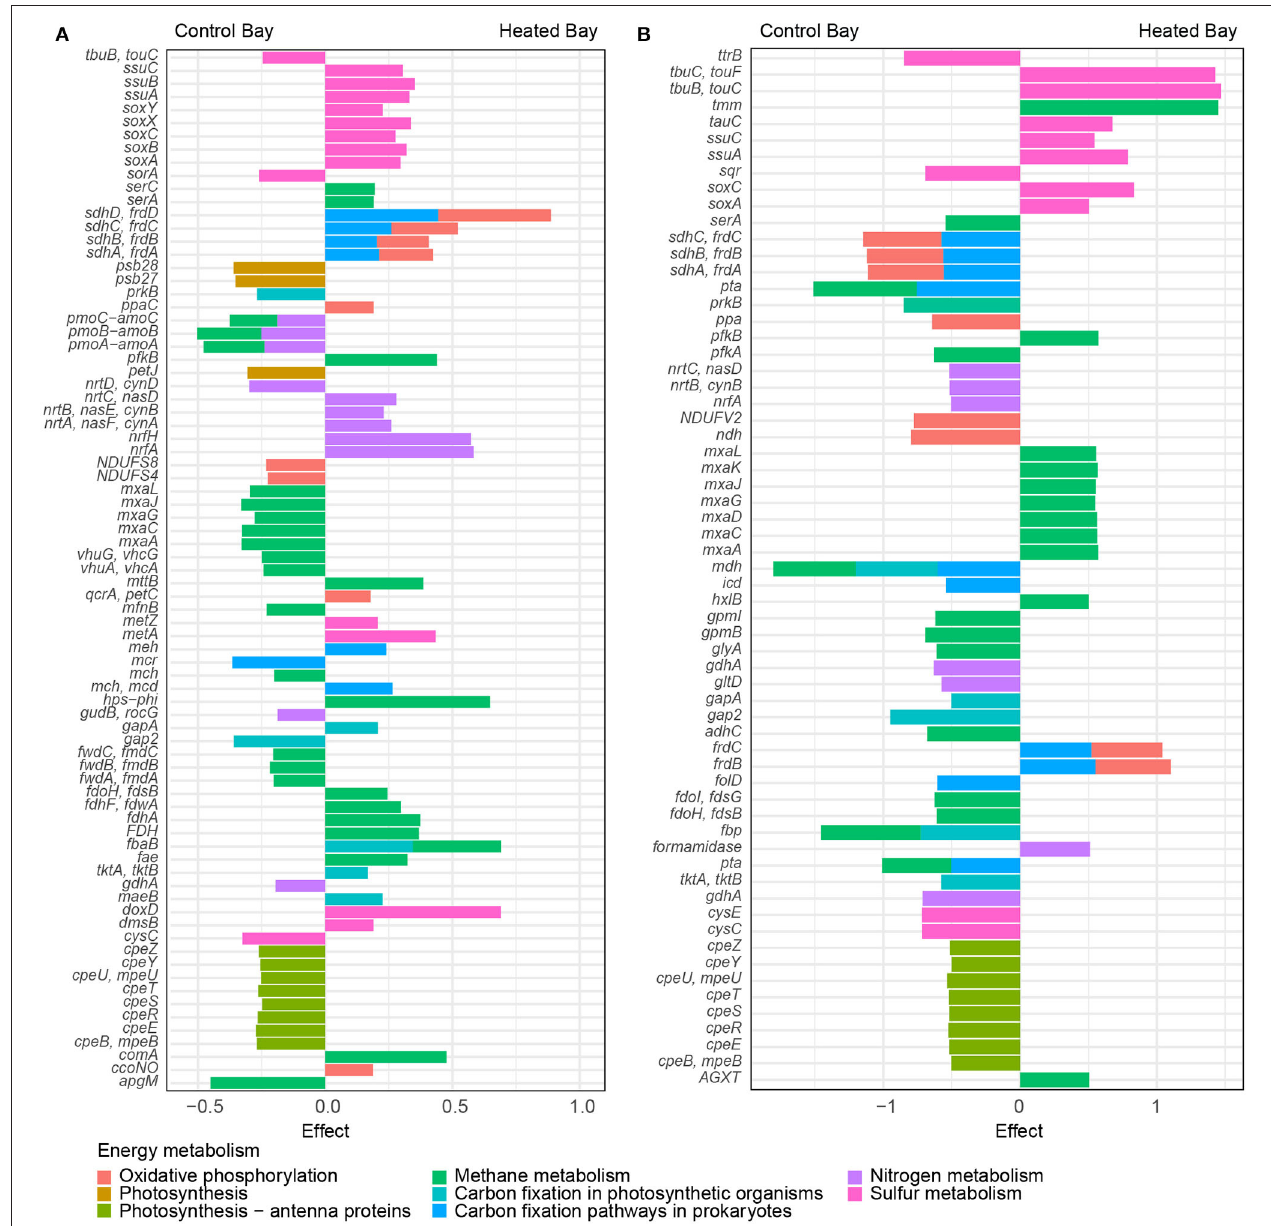
FIGURE 7 | Differential abundance of predicted metabolic response of highly abundant ASVs in bottom water and sediment over all sampling times. (A) Bottom water and sediment (B) of significant ( p < 0.05) differentially abundant genes between the heated and control bays predicted using the tool PICRUSt2.0. The colors show the different energy metabolism the genes are involved in based on KO identifiers. The axis shows the effect size of the significant differential abundances in the heated bay (positive values) and the control bay (negative values). The effect size shows the ratio between the abundance of the two conditions, similar to a Fold Change.